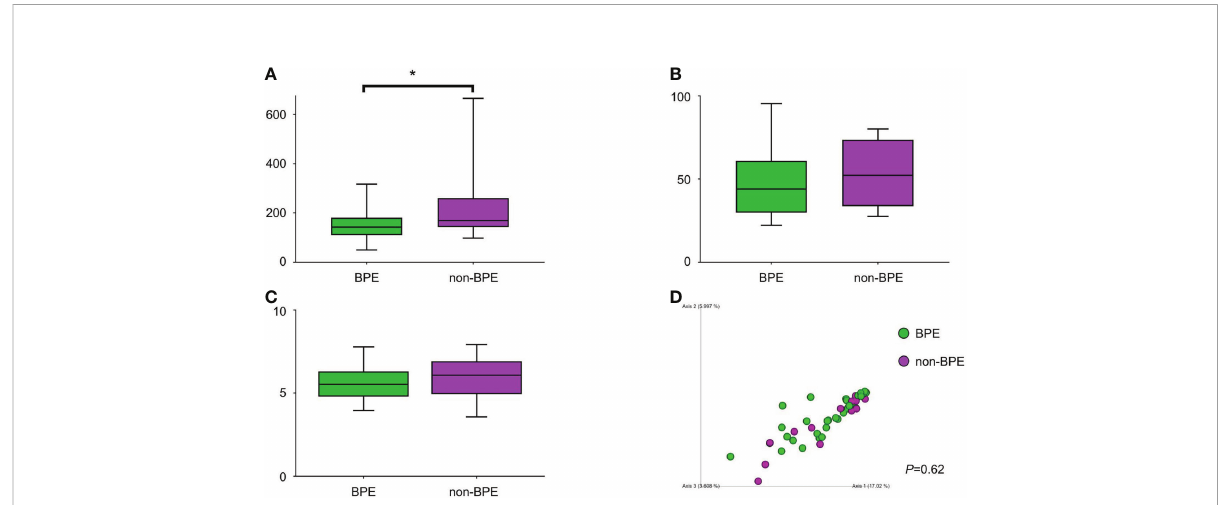
FIGURE 4 Comparison of alpha and beta diversity of prostate microbiota in the BPE and the non-BPE groups. (A) Chao1 index. (B) Faith ’ s PD index. (C) Shannon index. The data represent median (line in box) and interquartile range (box). (D) PCoA plots based on unweighted UniFrac distance showing the microbiota composition of prostate tissue in the PE and non-PE groups. * P < 0.05. BPE, benign prostate